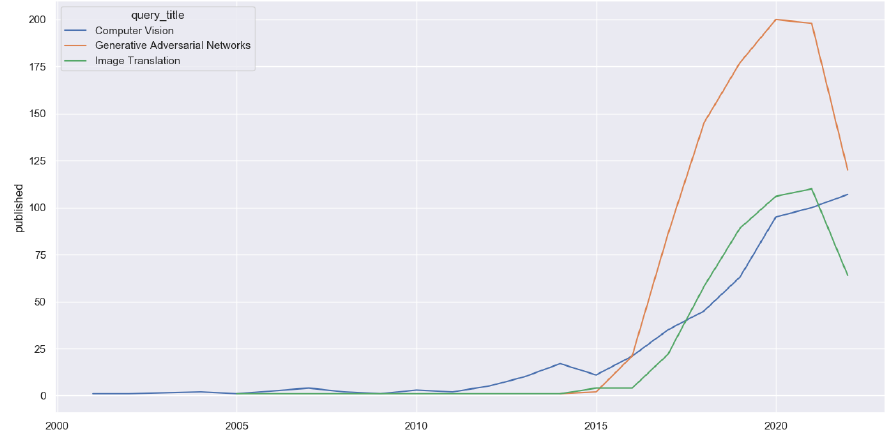
Figure 1. Number of papers published per year in deep learning, generative adversarial networks, image-translation and image-to-image translation. Papers from the ArXiV database were